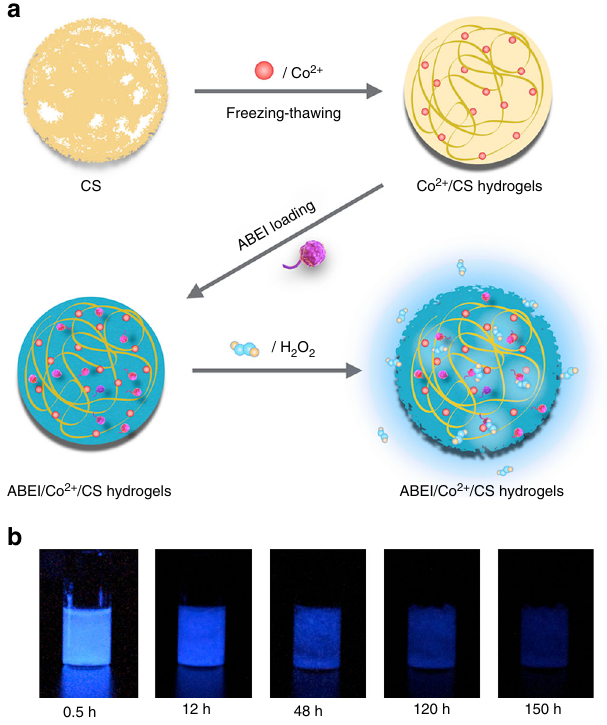
Fig. 1 Schematic illustration. a Preparation of ABEI/Co 2+ /CS hydrogels. b CL emission of ABEI/Co 2+ /CS hydrogels